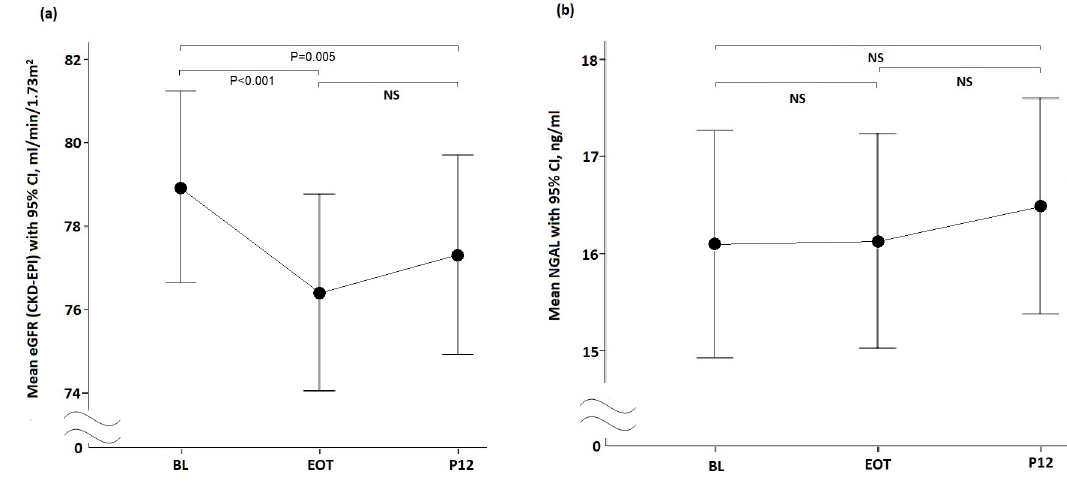
Fig 2. Overall eGFR and NGAL changes from the BL, EOT to P12 in CHC patients receiving DAA therapy. a. eGFR; b. NGAL.